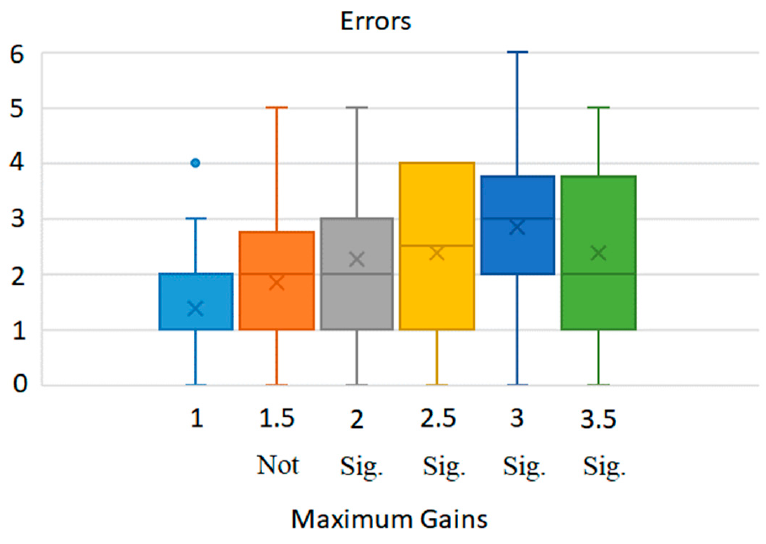
Figure 6. Number of errors committed by the participants based on the maximum gains. Table 4. Mean numbers of errors with standard deviation values and results of Wilcoxon signed-rank test.